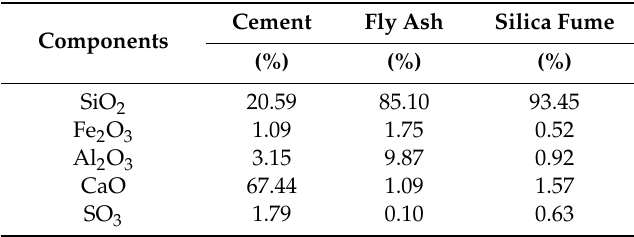
Table 2. The main chemical compositions of cement, fly ash, and silica fume (%).